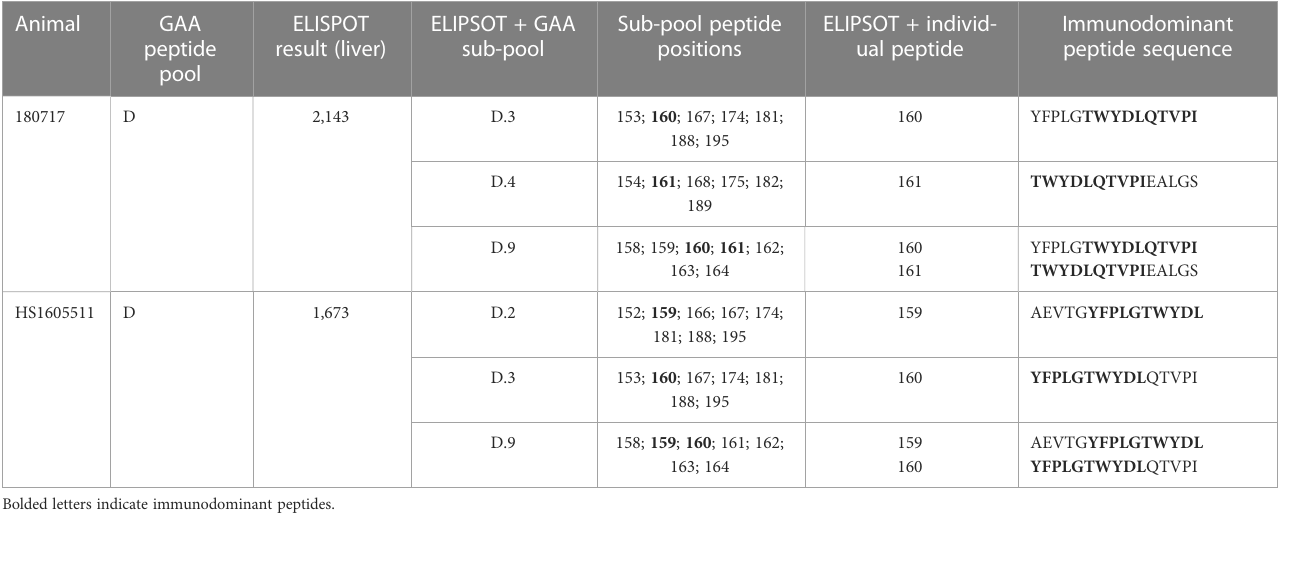
TABLE 1 ELISPOT response epitope mapping in liver lymphocytes.